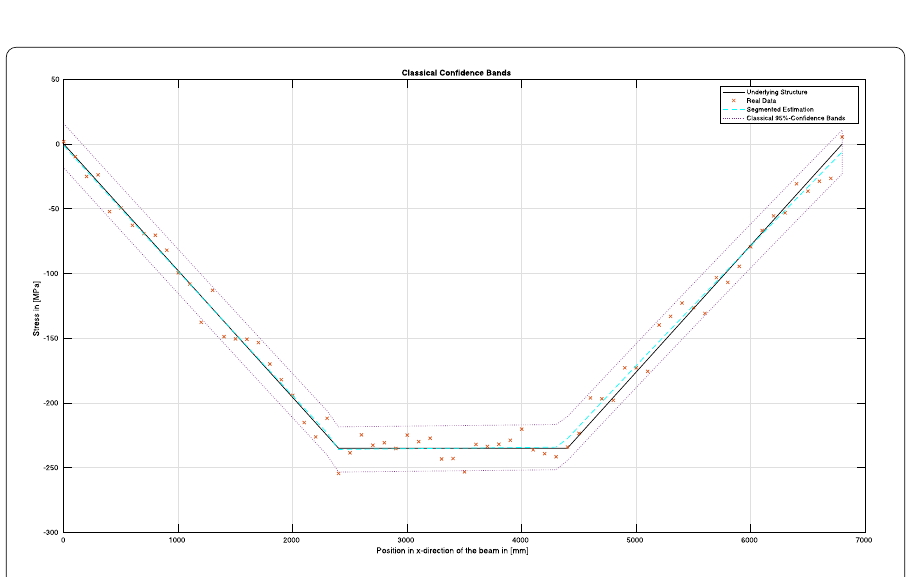
Figure 14 The analytic (blue) curve, the under idealised conditions recorded data (orange) the estimated curve (cyan) with confidence bands (purple)